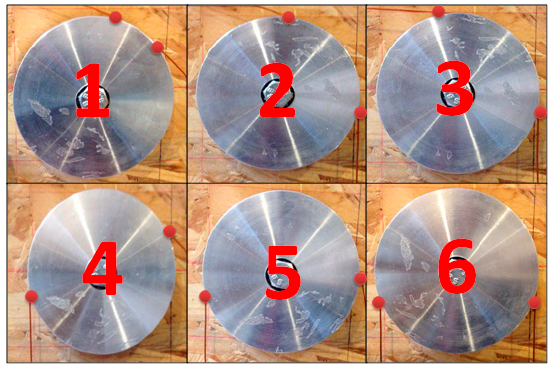
Figure 10. Assemblies for different lengths of wire on the disc.